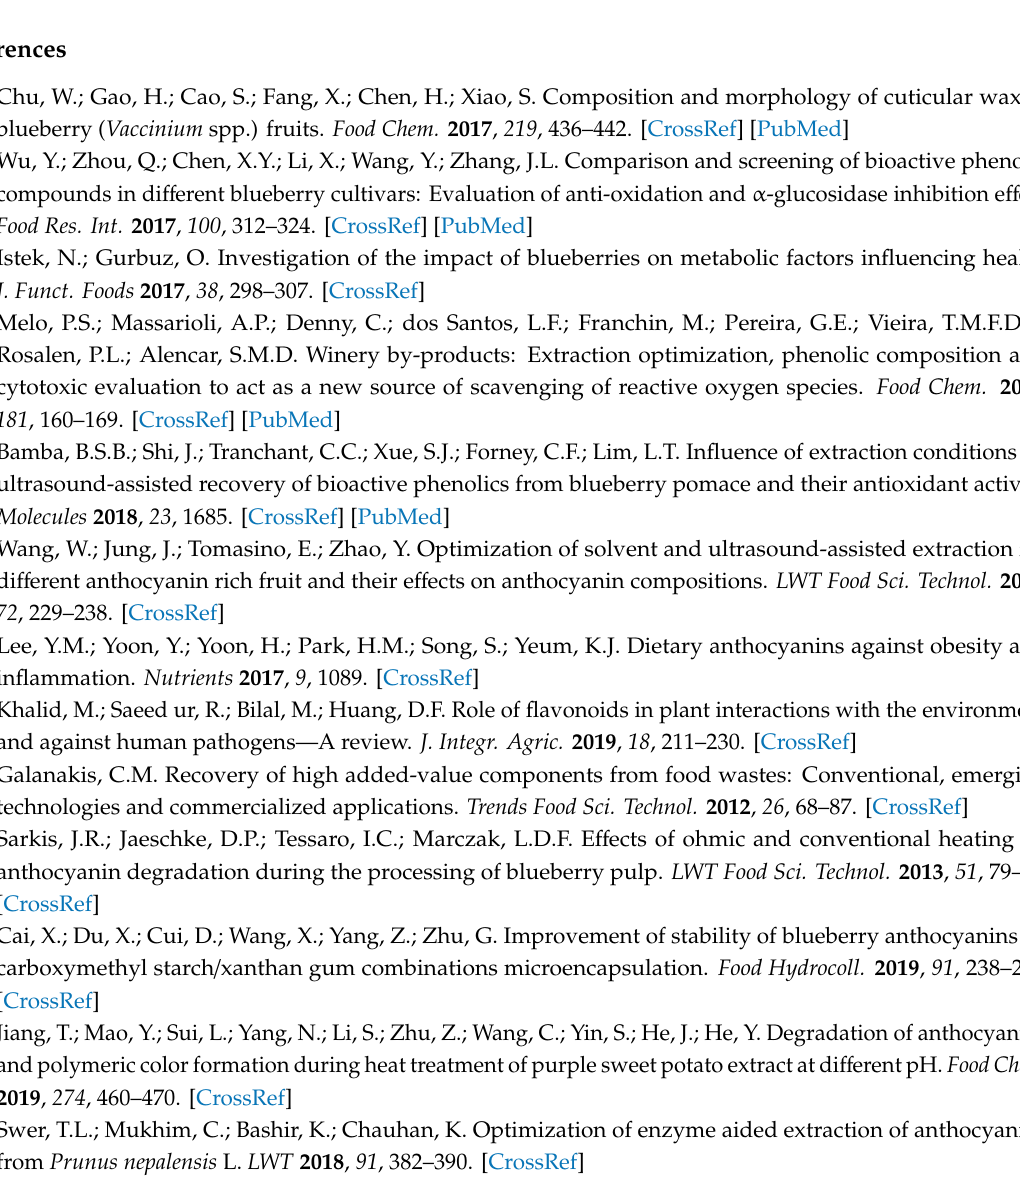
Supplementary Materials: The following are available online. Figure S1: The e ff ect of time on total anthocyanin extracted by conventional solvent extraction method. Di ff erent letters on bars show significant di ff erences ( p < 0.05), Figure S2: E ff ect of time on the stability of total anthocyanins in blueberry pomace under ultrasound treatment and conventional solvent extraction. Di ff erent letters on bars show significant di ff erences ( p < 0.05), Figure S3: E ff ect of temperature on the stability of total anthocyanins in blueberry pomace under ultrasound treatment and conventional solvent extraction. Di ff erent letters on bars show significant di ff erences ( p < 0.05), Figure S4: E ff ect of solvent on the stability of total anthocyanins in blueberry pomace under ultrasound treatment and conventional solvent extraction. Di ff erent letters on bars show significant di ff erences ( p < 0.05), Figure S5: E ff ect of interaction on total anthocyanins from blueberry pomace during ultrasound extraction course, Table S1: E ff ect of time on the stability of total anthocyanins in blueberry pomace under ultrasound treatment and conventional solvent extraction, Table S2: E ff ect of time on the stability of individual anthocyanin in blueberry pomace under ultrasound treatment and conventional solvent